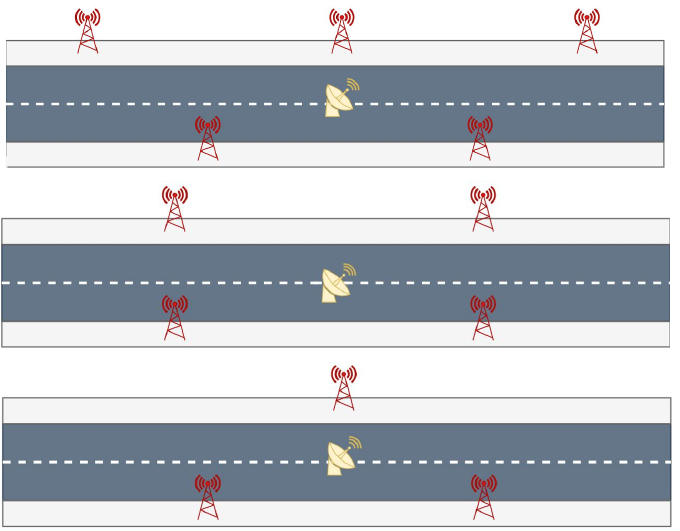
Figure 2. Possible network configurations. In order from the top: N5 (five staggered base stations), N4 (four paired base stations) and N3 (three staggered base